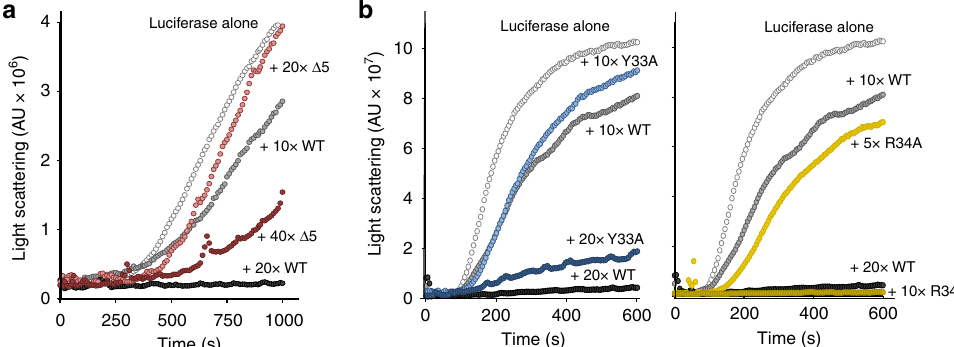
Fig. 2 N-terminal extensions of mTXNPx are crucial for in vitro chaperone activity. In fl uence of reduced Δ 5mTXNPx ( a ) or mTXNPxY33A/mTXNPxR34A ( b ) on the thermal aggregation of luciferase. Native luciferase (0.1 μ M) was incubated in the absence or presence of different ratios of mTXNPx at 42 °C. Light scattering (expressed in arbitrary units, A.U.) was monitored at 360 nm. All reactions were carried out in the presence of 0.2 mM DTT to maintain reduction of mTXNPx. Puri fi ed wt mTXNPx was used as positive